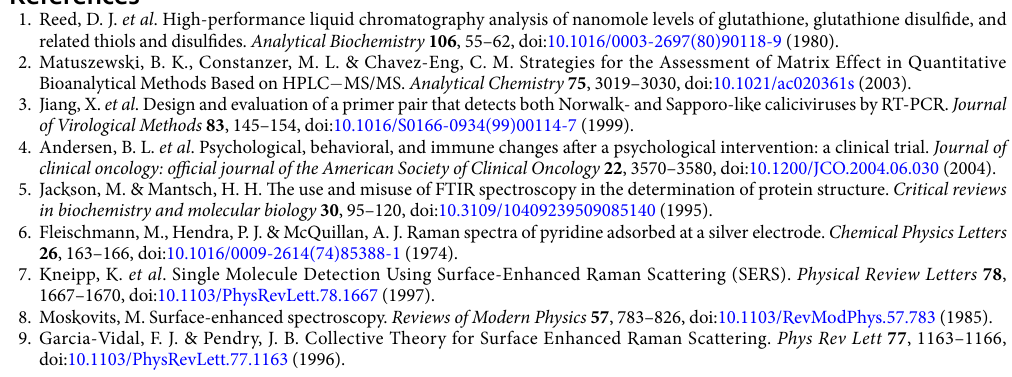
was equal to 10 nM, which met the demand of MG residue detection in fish farm water. Moreover, the results exhibited a strong linear dependence (R 2 = 0.999) from 10 nM to 100 μ M for MG quantitative analysis. In short, such a low-cost, high-sensitivity SERS substrate substantially outperformed the commercialized SERS substrate, and promised a rapid and accurate screening for both qualitative and quantitative analysis of toxic residue trace detection.